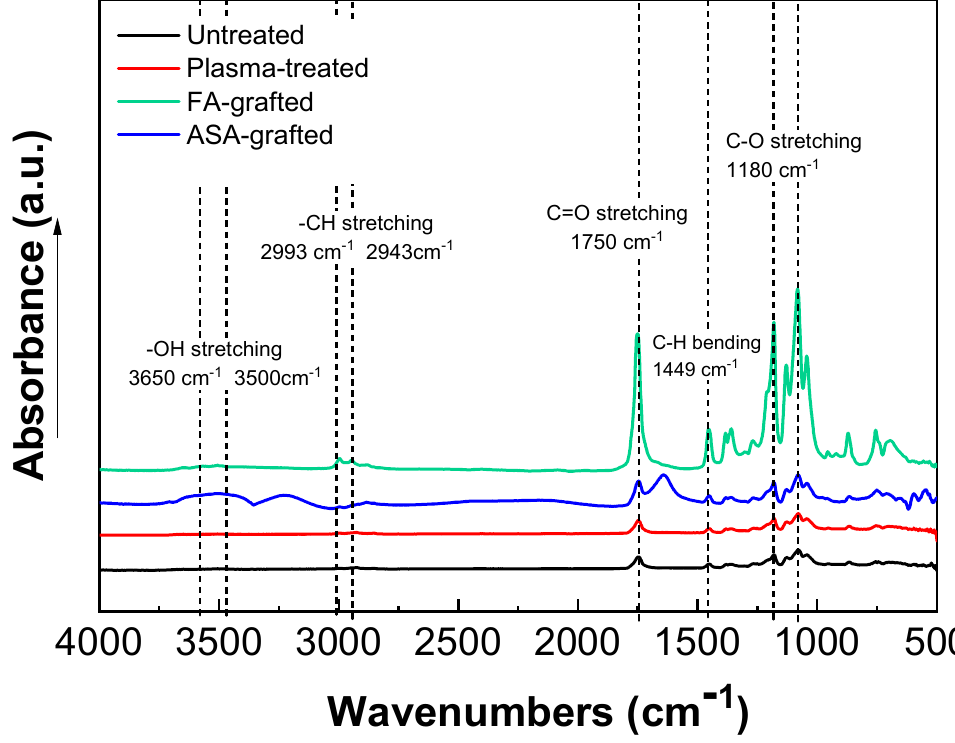
Figure 3. Fourier transform infrared spectroscopy (FTIR) spectra of PLA samples.